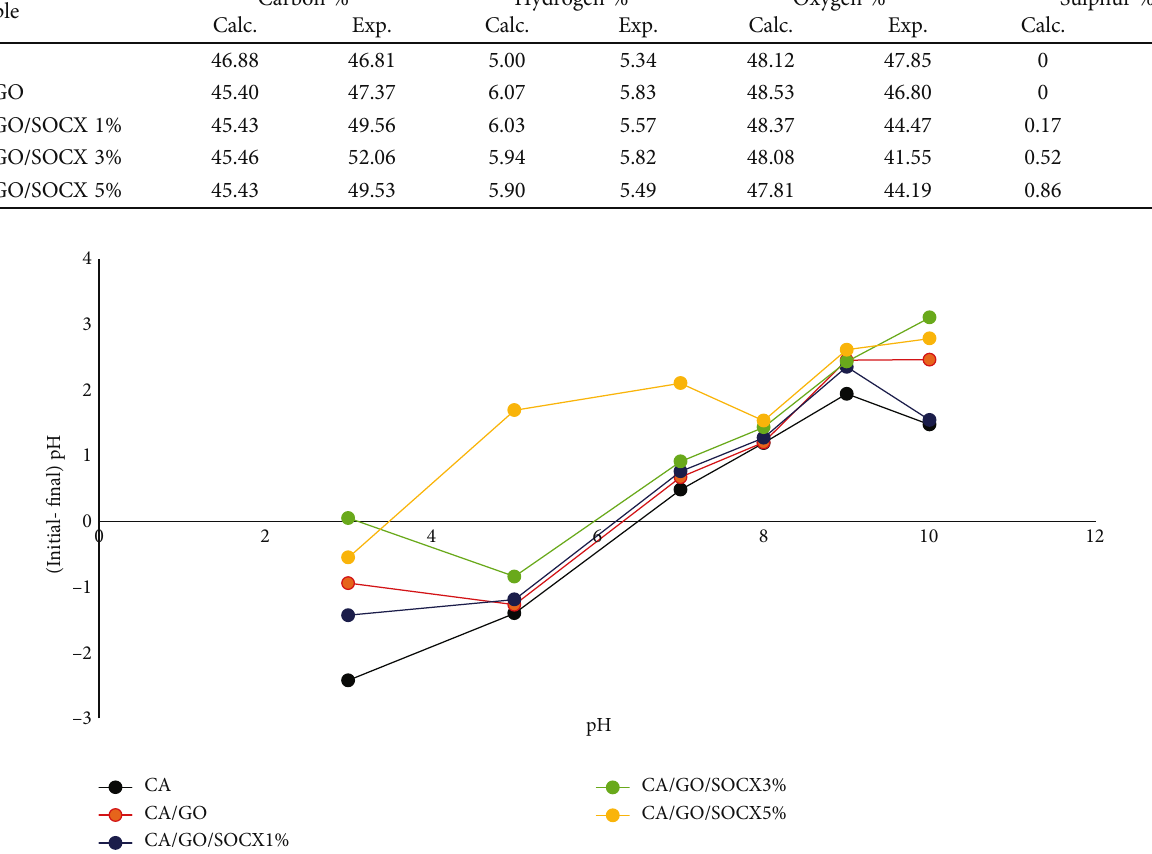
) for CA, GO functionalized CA nano fi ber, and GO functionalized CA with di ff erent p -SOCX PZC study, 0.5ml of 0.1M NaNO solution 25mg/L of adsorbent dosage and 24 hours contact PZC 3 ,